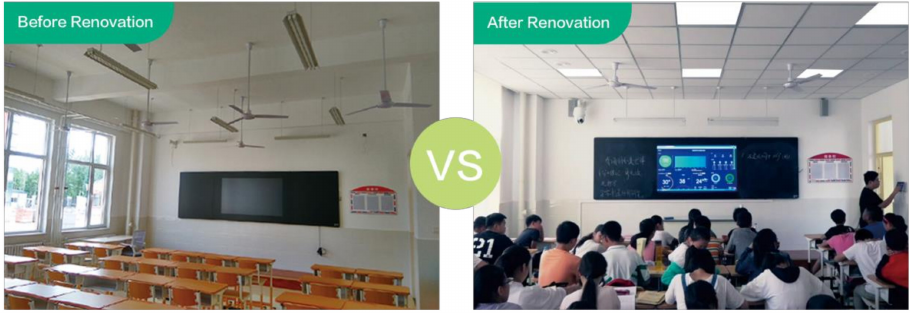
Figure 19. Comparison before and after classroom